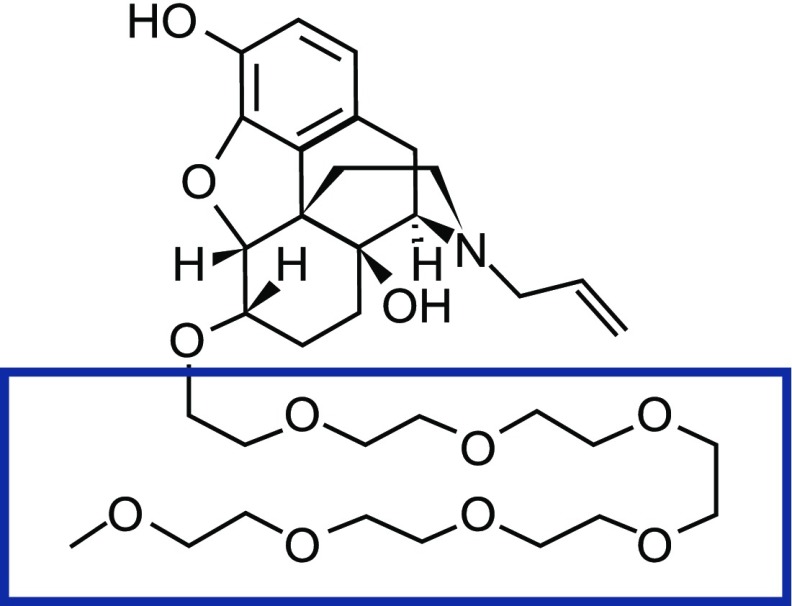
Chemical structure of naloxegol, a PEGylated derivative of naloxol, which is derived from naloxone. The box encompasses the low molecular weight polyethylene glycol (PEG) chain that is covalently bound to the morphinan ring-based structure of naloxone.